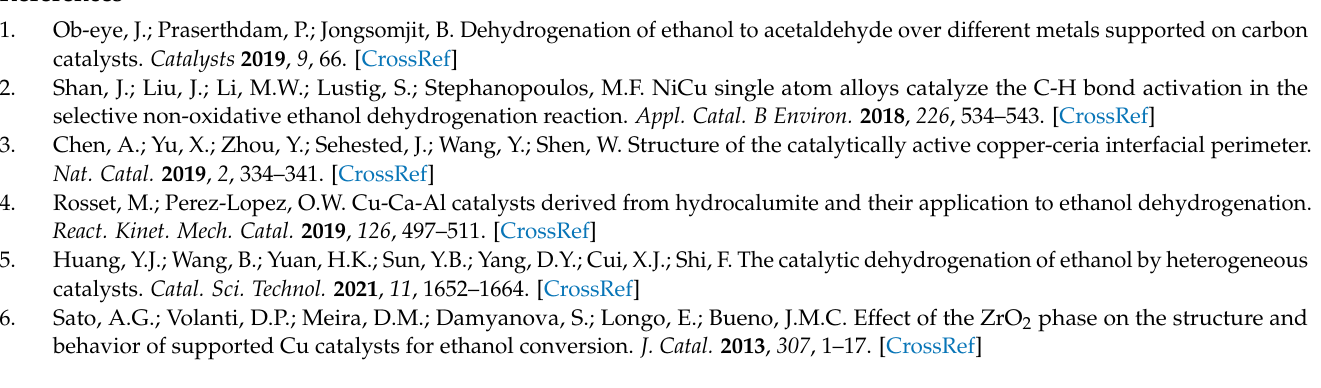
sample; Figure S5: XRD pattern of the spent Cu/KIT-6 catalyst after running for 96 h; Figure S6: TEM image of the spent Cu/KIT-6 catalyst after running for 96 h; Figure S7: In situ FTIR spectra of the spent Cu/KIT-6 catalyst exposed to 10% O 2 /He atmosphere at 250 ◦ C for 1 h; Figure S8: ( a ) ethanol conversion and ( b ) acetaldehyde selectivity and yield of the Cu/KIT-6 catalysts with different Cu loading; reaction condition: a reactant ethanol stream of 2 kPa balanced by N 2 under atmospheric pressure and WHSV of 13.67 mmol g − 1 Cu h − 1